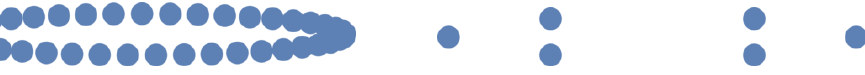
Figure 5 . One e(cid:11)ect of discreteness on topology. Left: a deformed well-sampled circle. Such features can accomodate more deformation than their poorly-sampled counterparts and still be recovered by persistent homology. Right: a deformed poorly-sampled circle. The deformation overtakes the characteristic distance between points, and the 1-cycle will be poorly recovered by persistent